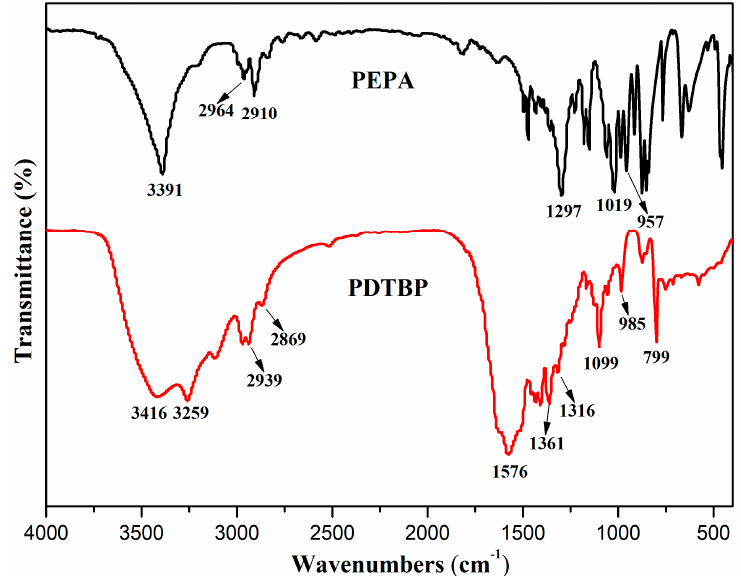
Figure 1. FTIR spectra of PEPA (2,6,7-Trioxa-1-phosphabicyclo-[2,2,2]octane-4-methanol-1-oxide) and PDTBP.